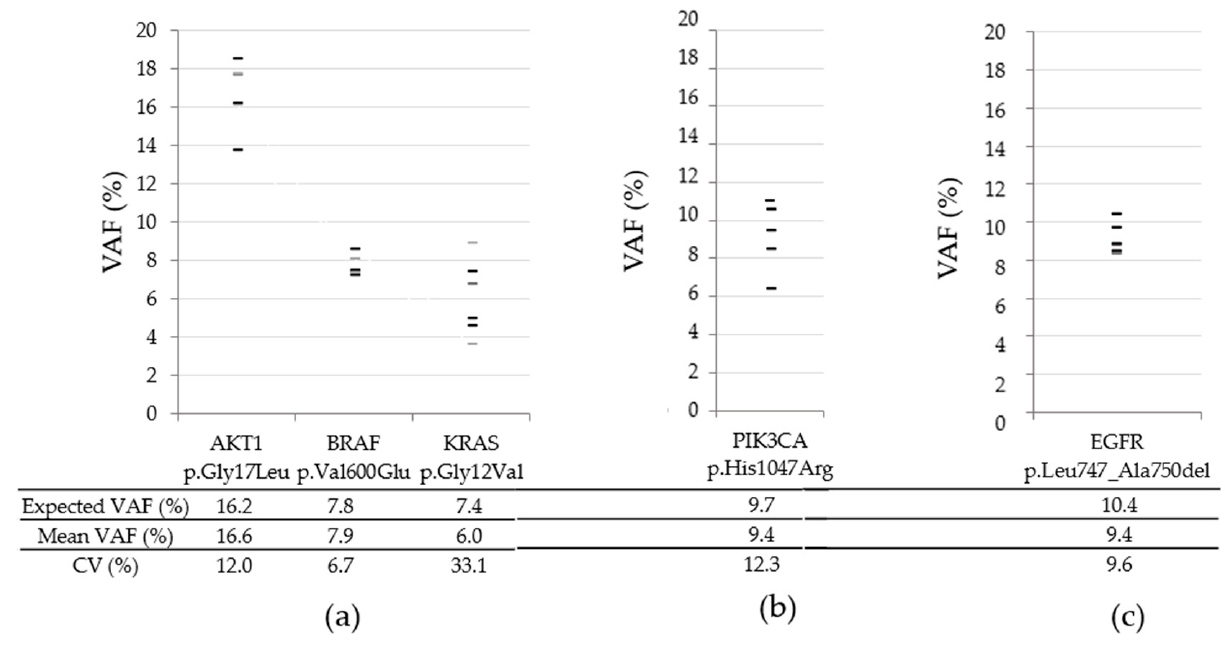
(Figure 3). The VAF coefficients of variation ranged from 6.7% ( BRAF p.Val600Glu) to 33.1% ( KRAS p.Glu12Val).